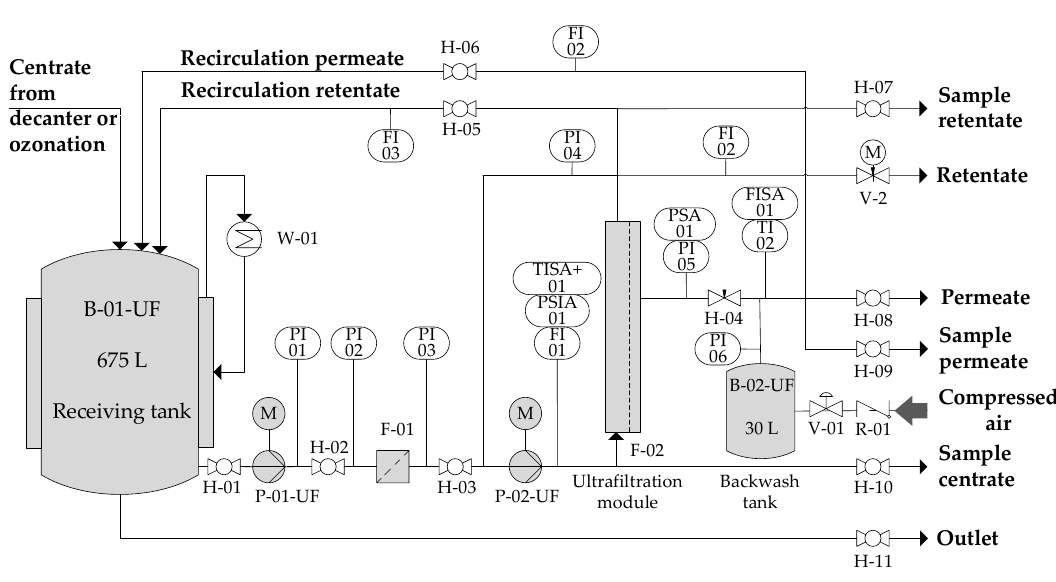
Figure 3. Process flowsheet ultrafiltration pilot plant.